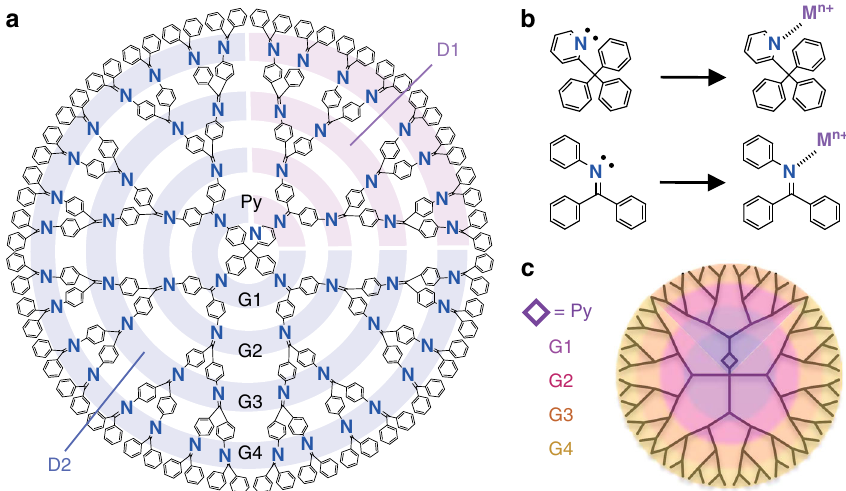
Fig. 2 The DPA dendrimer template. a Molecular structure of the generation 4 dendrimer (PyTPM-G4). b Complexation of metal salts at the imine sites of pyridine and DPA. c Potential gradient on PyTPM-G4. (purple: higher electron density, yellow: lower electron density). Py pyridine, G generation, and D